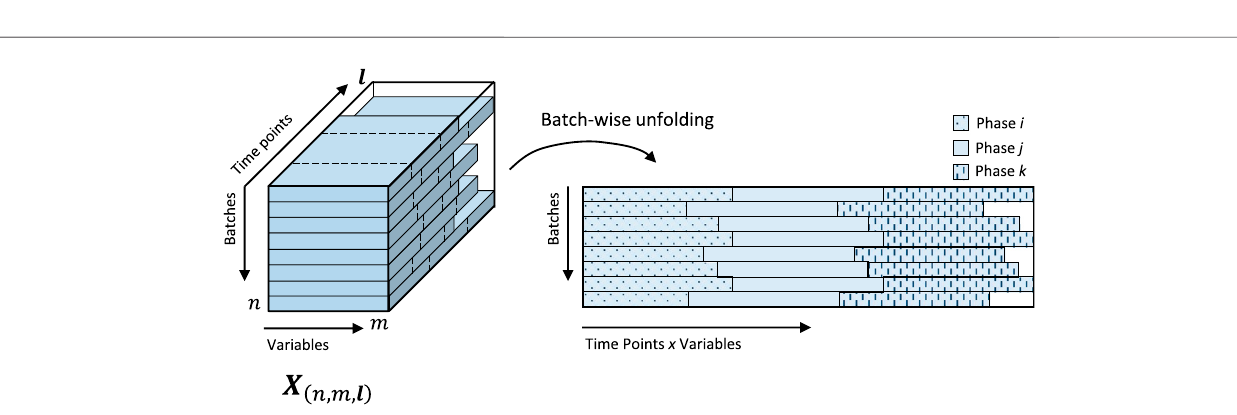
FIGURE 2 | Data structure in multi-phase batch processes.